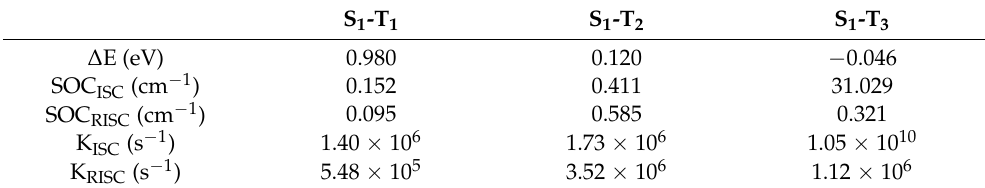
Table 3. Calculated SOC constants, energy level difference and rates of ISC (K ISC ) and RISC (K RISC ) between the singlet and triplet states of BP(OH) 2 in